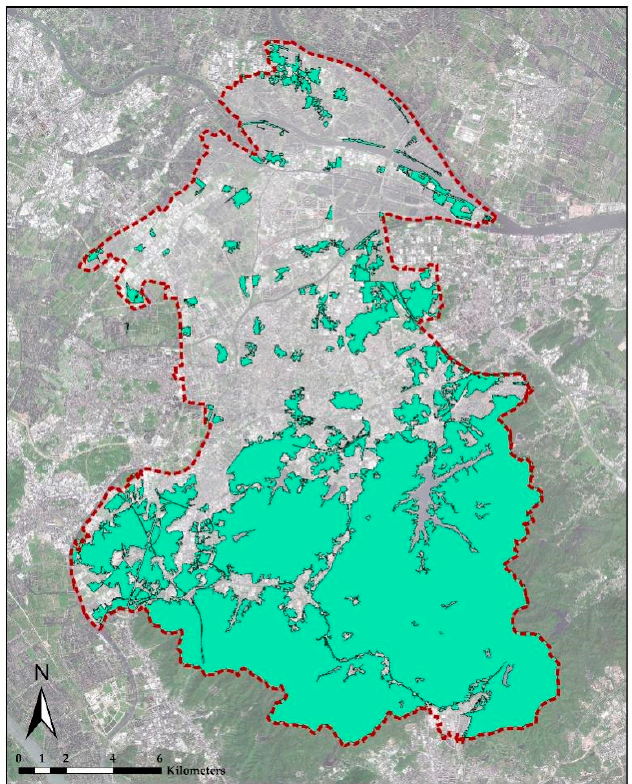
Figure 8. UGI patches interpreted from GF6.